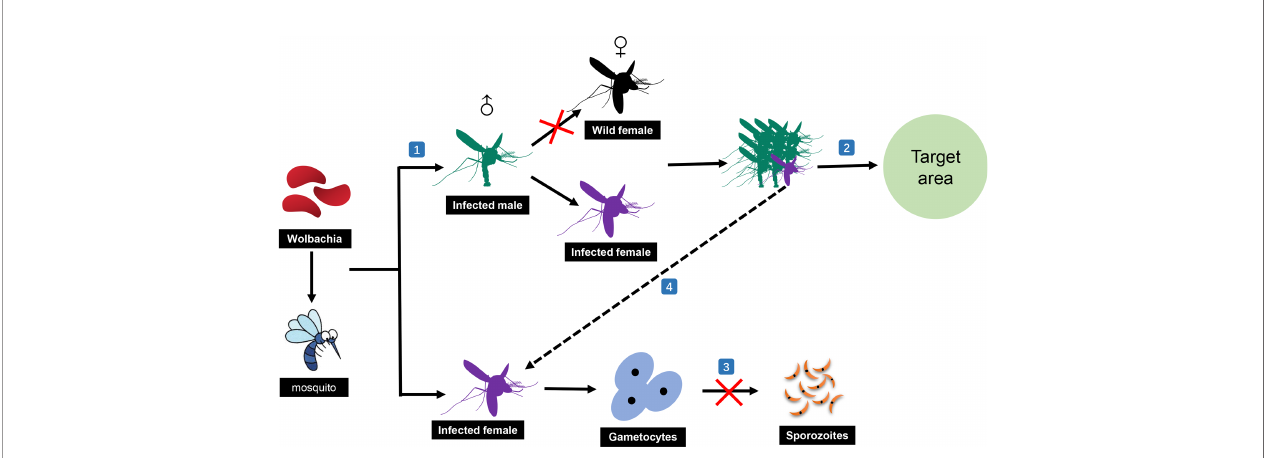
FIGURE 2 | Malaria transmission-blocking strategies based on Wolbachia . (1) Male mosquitoes infected with Wolbachia can only mate with female mosquitoes infected with the same Wolbachia to complete normal reproduction. (2) Numerous infected male mosquitoes can be released in the target area to kill the mosquitoes in the area and thus stop the spread of malaria. (3) Wolbachia can also prevent the normal sporozoites development of Plasmodium in mosquitoes. (4) Infected female mosquitoes accidentally released with the numerous infected male mosquitoes can still block the spread of malaria through the pathogen suppression ability of Wolbachia